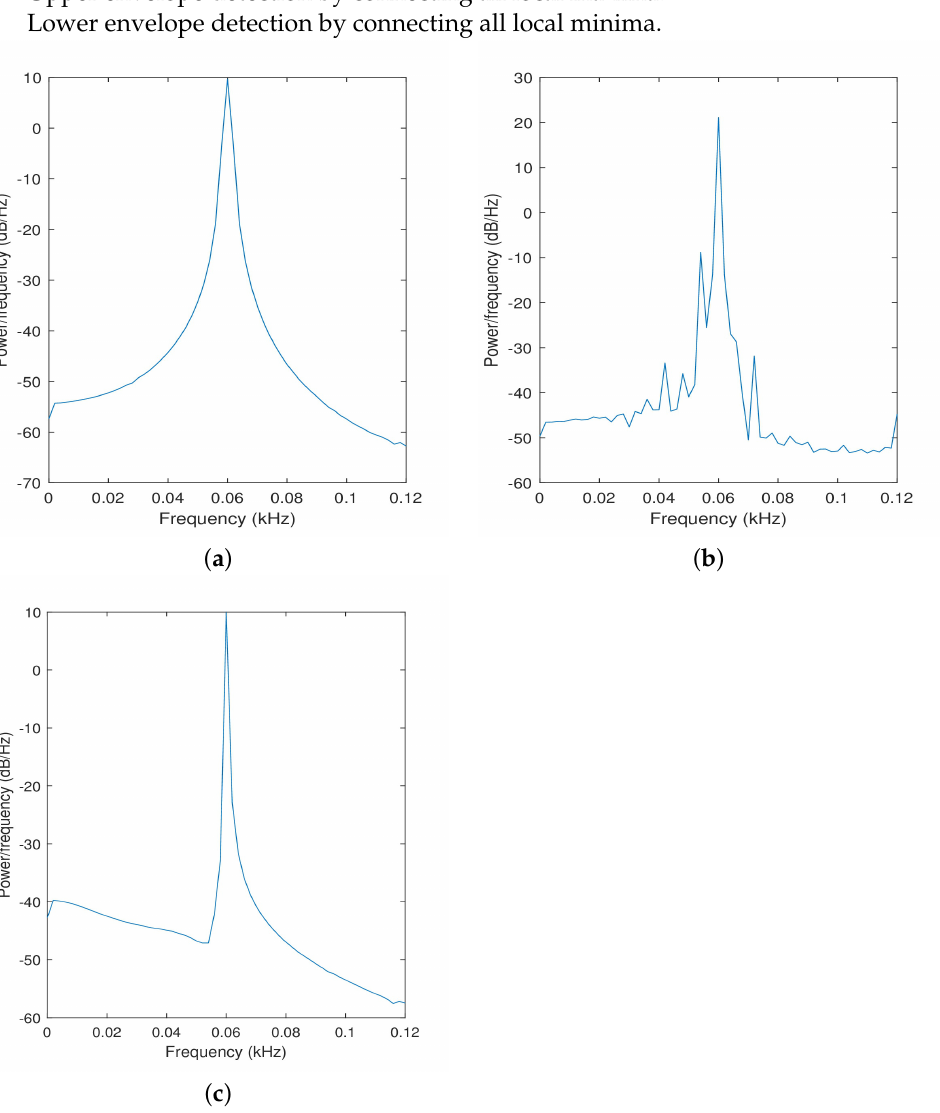
Figure 3. Power spectral density of stator current. ( a ) Healthy condition; ( b ) one broken bar at full load; ( c ) one broken bar at no